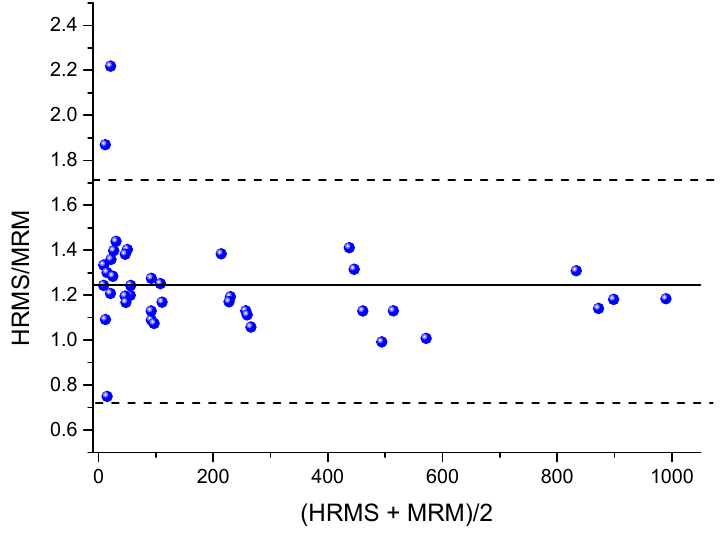
Figure 5. A plot of ratios of concentrations shown by the HRMS method (PRM) to those shown by the MRM method versus the mean sample concentrations revealed by the two methods (blue dots). The solid black line denotes the mean ratio of 1.24, and the dashed lines represent the 95% confidence interval.